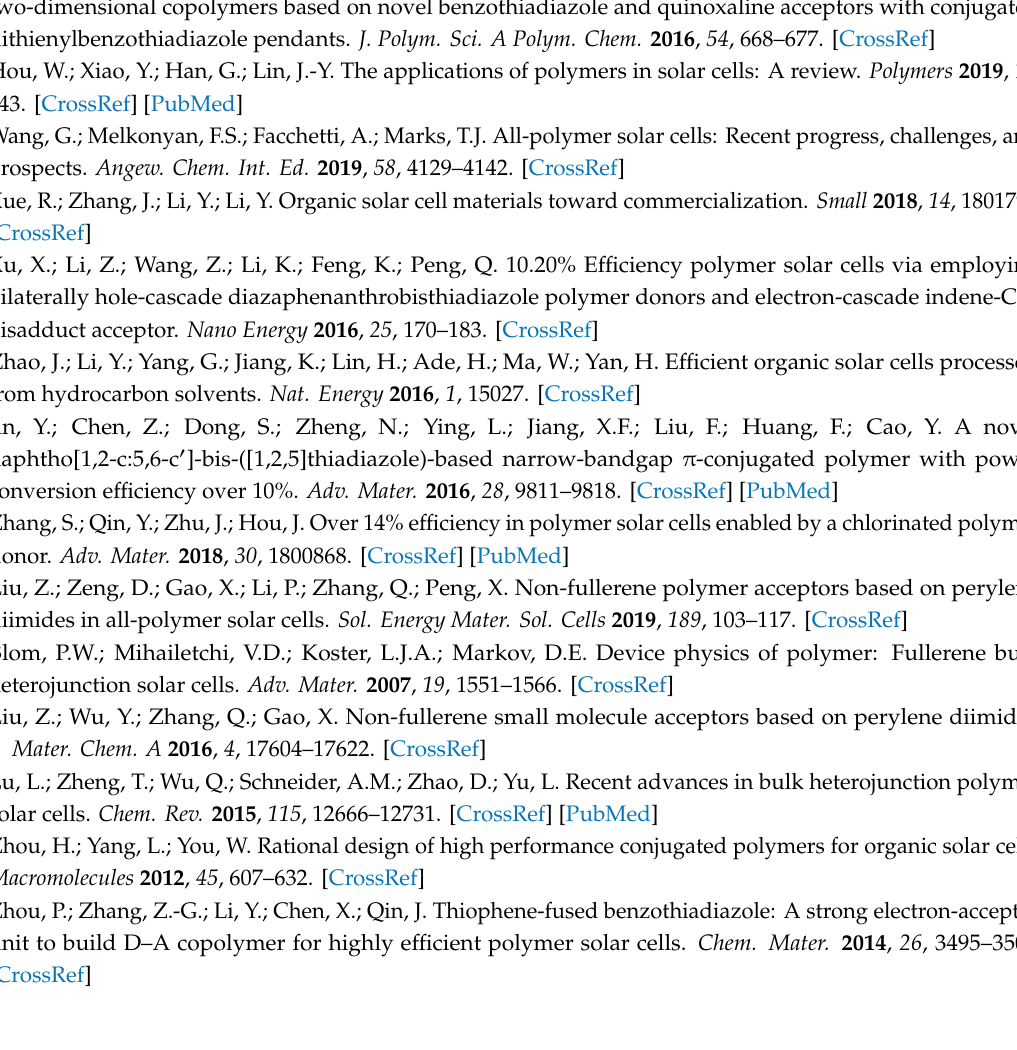
Table S1: the best photovoltaic parameters of the PSCs, Table S2: the photovoltaic parameters of the devices based on